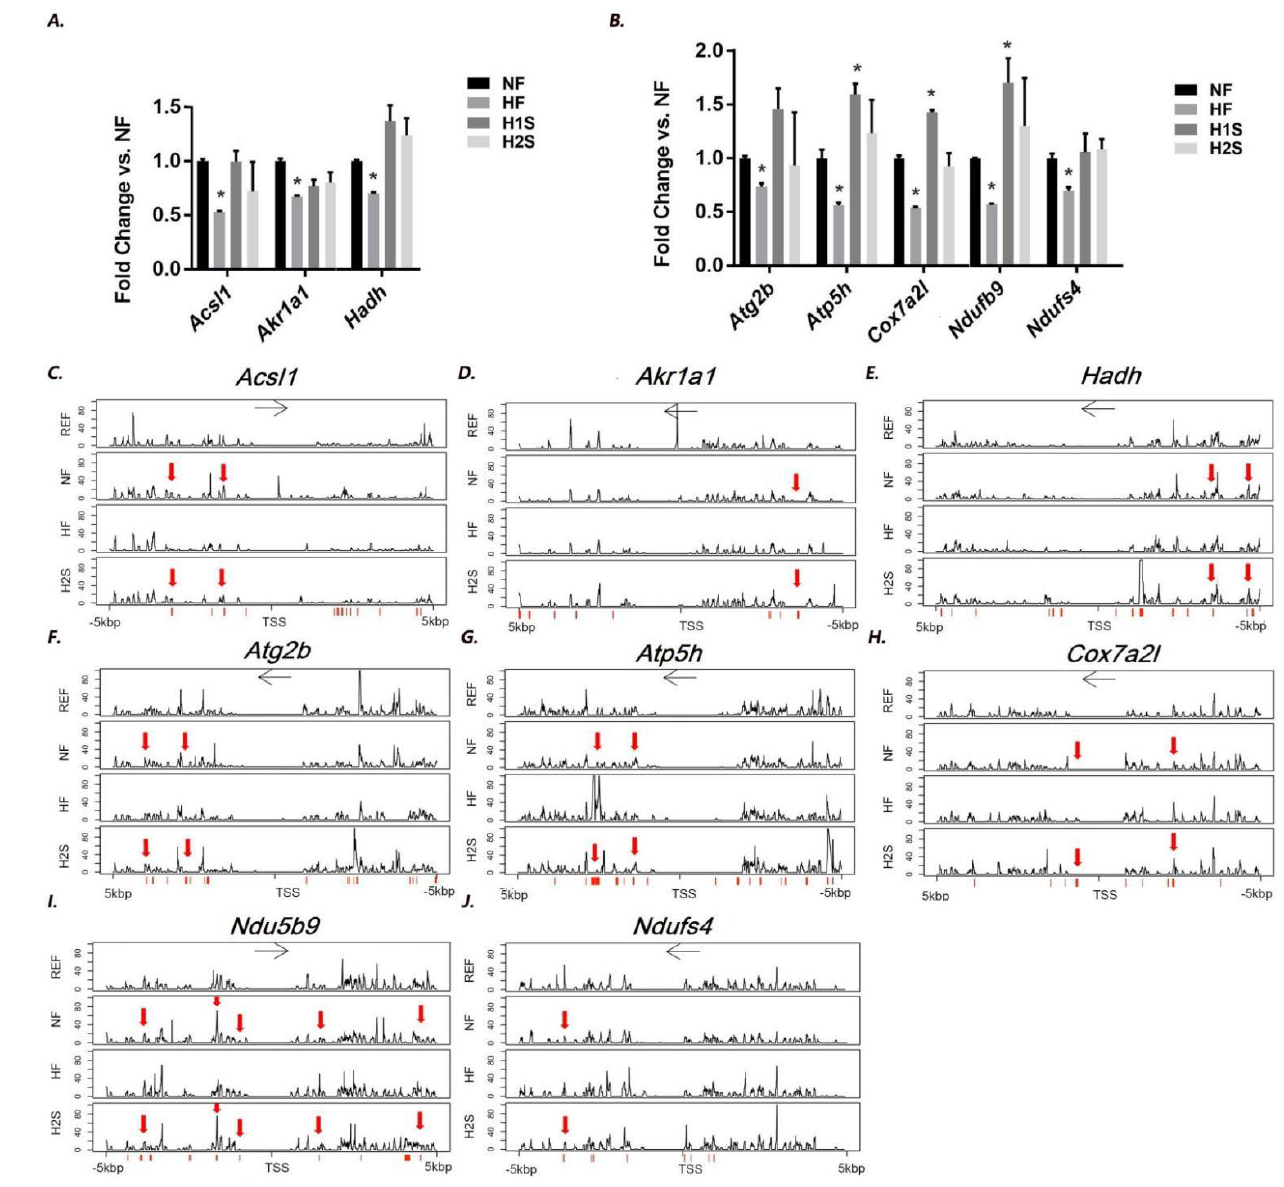
Figure 5. Genes involved in lipid metabolism and oxidative phosphorylation, whose hepatic expression was associated with DNA methylation modification, were identified in the offspring liver. ( A ). Gene expression levels of Acsl1, Akr1a1, and Hadh were measured by real-time PCR in the male offspring livers. Data are presented as the mean ± SE, n = 5. * indicates p < 0.05 vs. NF group. ( B ). Gene expression levels of Atg2b, Atp5h, Cox7a2l, Ndufb9 and Ndufs4 were measured by real-time PCR in the male offspring livers. ( C – J ). DNA methylation patterns of a 10 kbp genomic region extending from 5 kbp upstream of the TSS to 5 kbp downstream of the TSS were analysed by WGBS. The y -axis indicates the percentage of methylation at each DNA nucleotide. Only those DNA methylation changes of more than 20% were considered potential methylation pattern changes. The x -axis indicates the location of each DNA nucleotide around the TSS. Typical DMRs induced by maternal HF diet but recovered by H2S diet are labeled by red arrow. Modified CpG loci are labeled with short red lines on the x -axis.